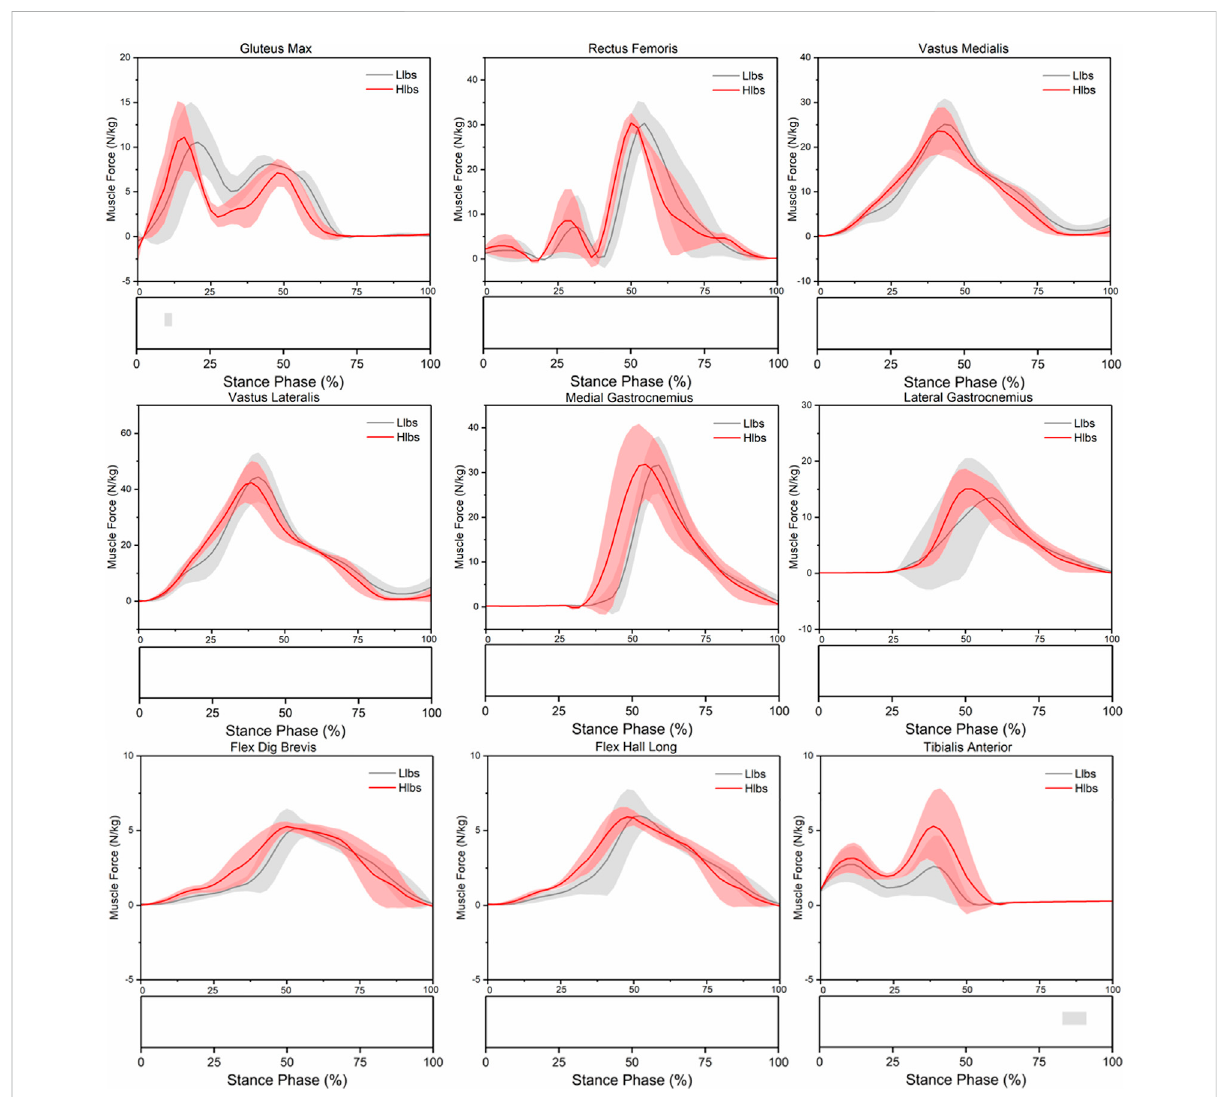
FIGURE 4 Lower limb muscle force waveforms of mean and standard deviation over the stance phase of two shoe conditions. Signi fi cant differences ( p < 0.05) are highlighted (grey horizontal bars at the bottom of the fi gure) during corresponding periods from SPM1d